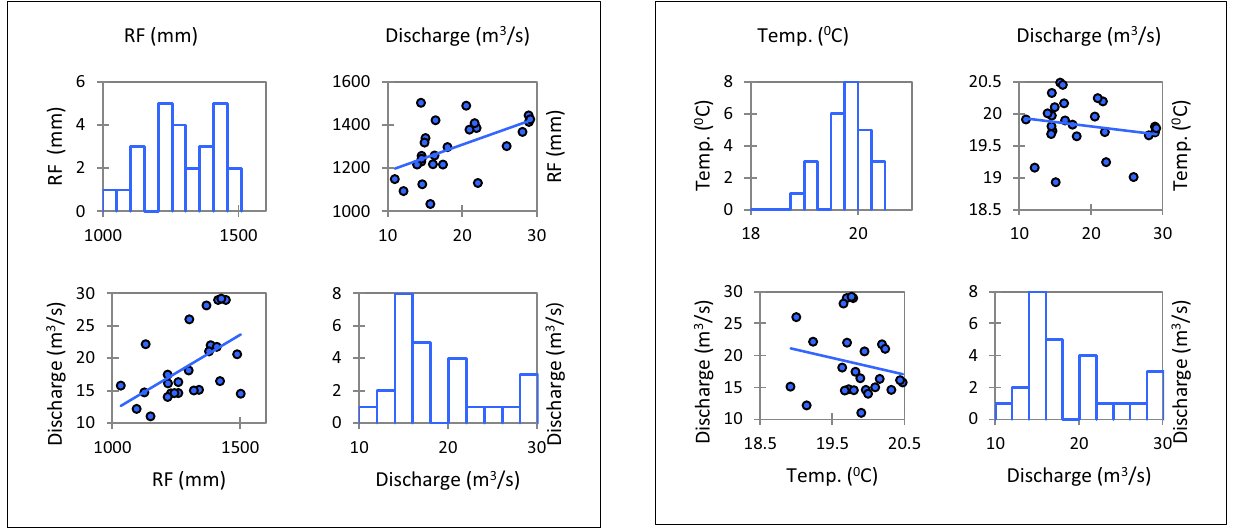
Fig. 11 Correlation coefficient between rainfall with discharge and temperature with